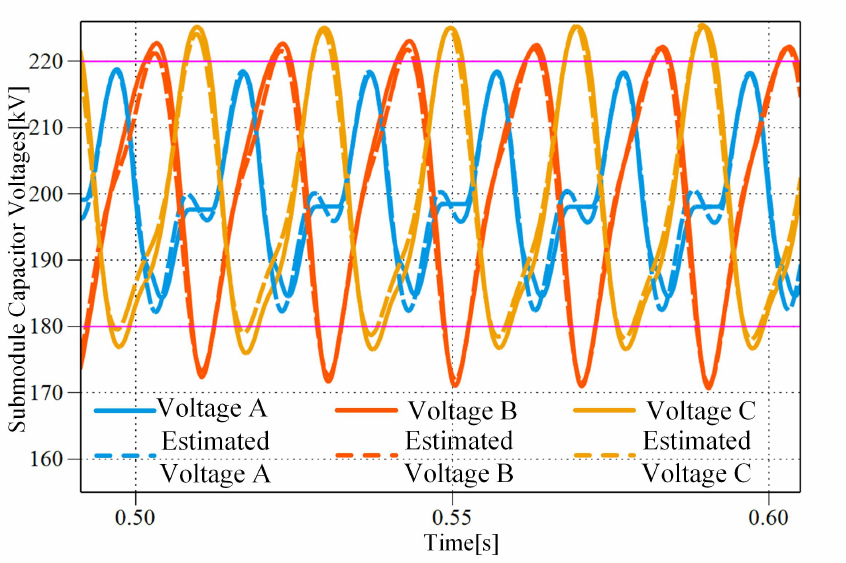
Figure 4. Estimated submodule-capacitor voltages and the simulated submodule-capacitor